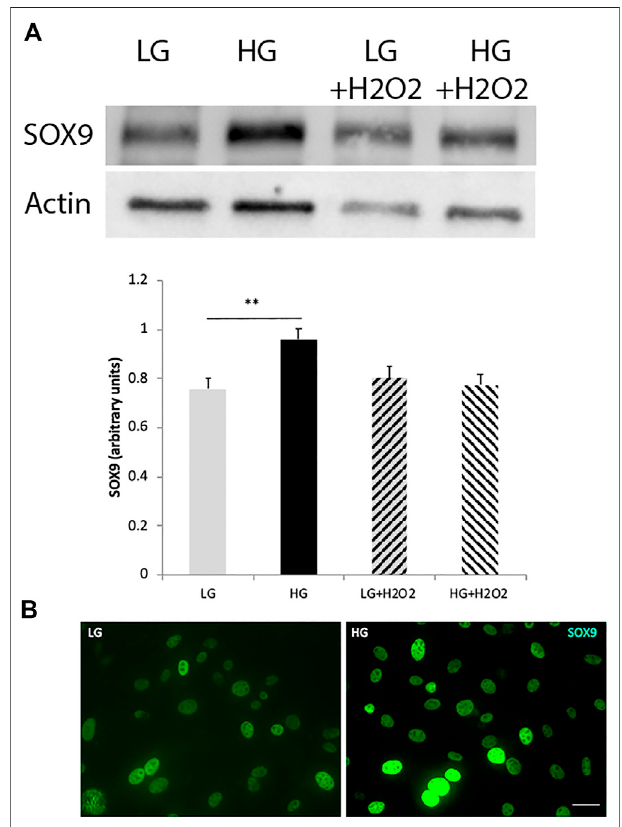
FIGURE2| ThelevelsofthereprogrammingfactorSOX9increaseunder high glucose concentrations. (A) Western blot analysis showed an increase in SOX9 levels in MGs cultured with high glucose (HG, 25 mM), while oxidative stress (H 2 O 2 100 μ M) had no effect on this factor ’ s levels. Quanti fi cation of bands was performed using the ImageJ program. β -actin was used for normalization. Data are mean ± SE of three independent experiments, ** p < 0.01. (B) Representative immuno fl uorescence con fi rmed the increase in SOX9 levels (green). Scale bar: 20 μ m. Images show a representative picture from three independent experiments.